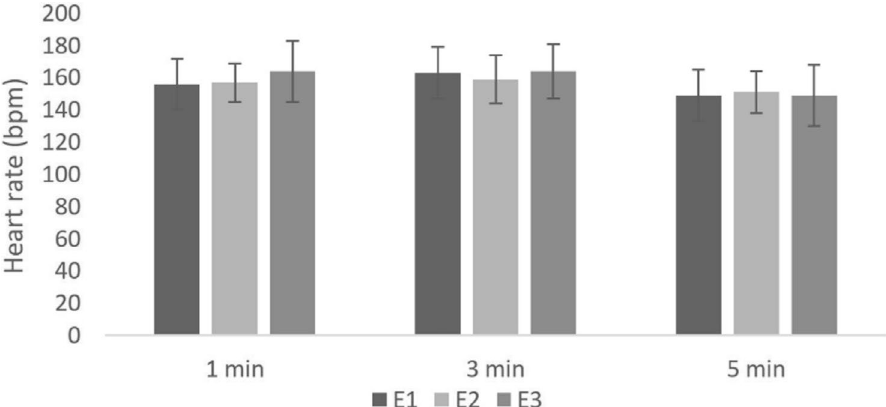
Figure 2 - The heart rate corresponding to the Blood Glucose Threshold for each Evaluator in E1 = Evaluator 1, E2 = Evaluator 2, E3 = Evaluator 3.